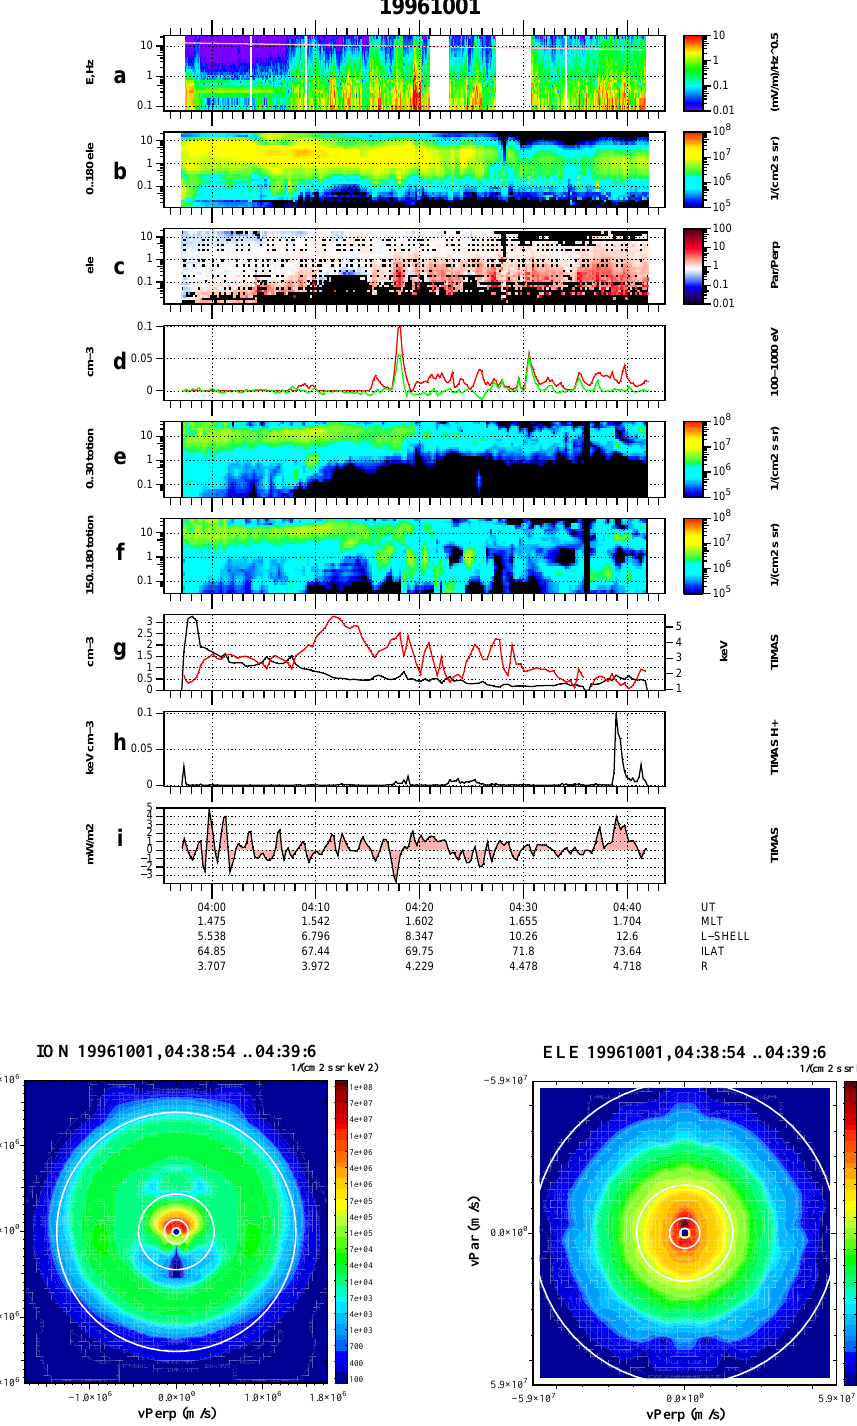
Fig. 12. Example of an event containing a 3/4-consumed shell distribution (i.e. only the small pitch-angle part of the downgoing part is intact, the rest of the distribution has been flattened out). In all PSBL events we have looked at there is always an upgoing ion beam embedded within the shell. Format is similar to Fig. 9. One-count level is 100 times smaller than shell